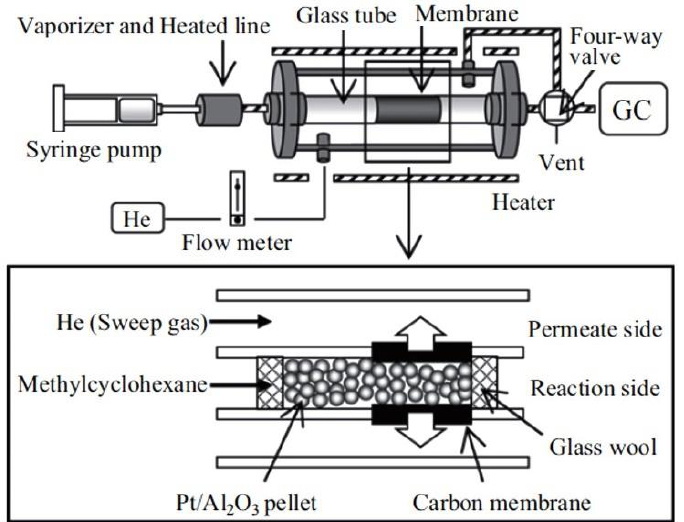
Figure 6. Schematic diagram of in-situ catalytic membrane reactor system: pelletized catalyst filled inside the tubular membrane reactor. Adapted from [32] with permission.